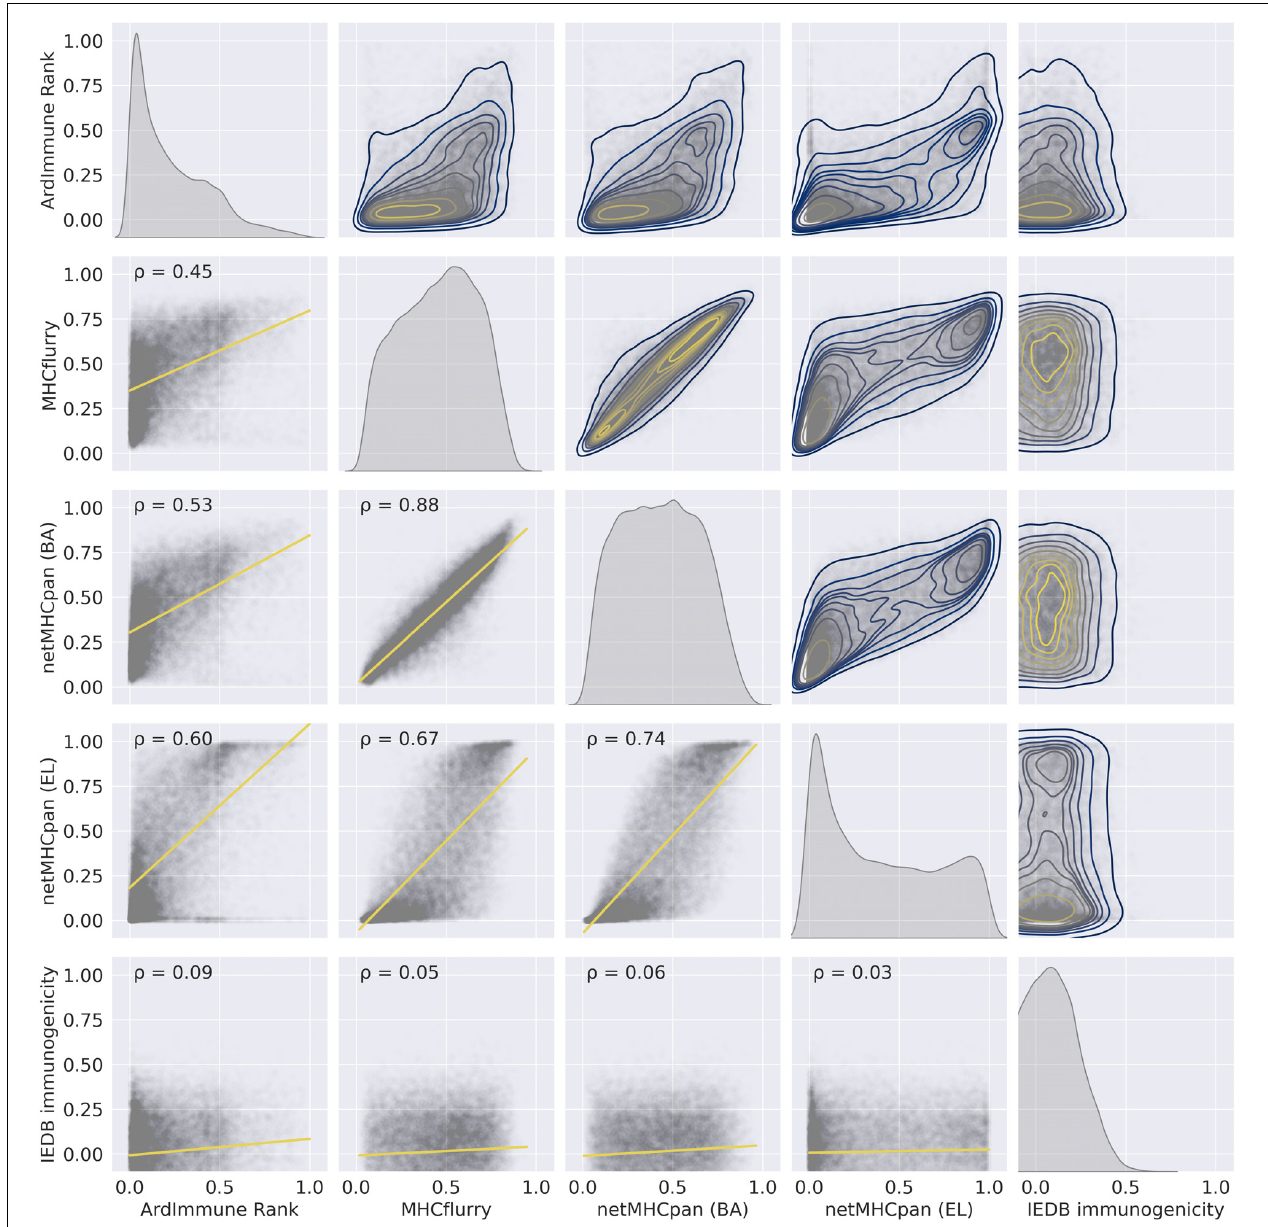
FIGURE 4 | The pairwise relationships between the predictions of the selected models on the training set – (1) ArdImmune Rank, (2) MHCflurry, (3) netMHCpan (BA), (4) netMHCpan (EL), and (5) IEDB immunogenicity. Lower triangle – scatterplots with linear regression models fitted (yellow lines) and Pearson’s correlation coefficients (PCC) that measure linear correlations between two variables. Diagonal and upper triangle – the prediction distributions obtained by kernel density estimations (1D-KDE and 2D-KDE,